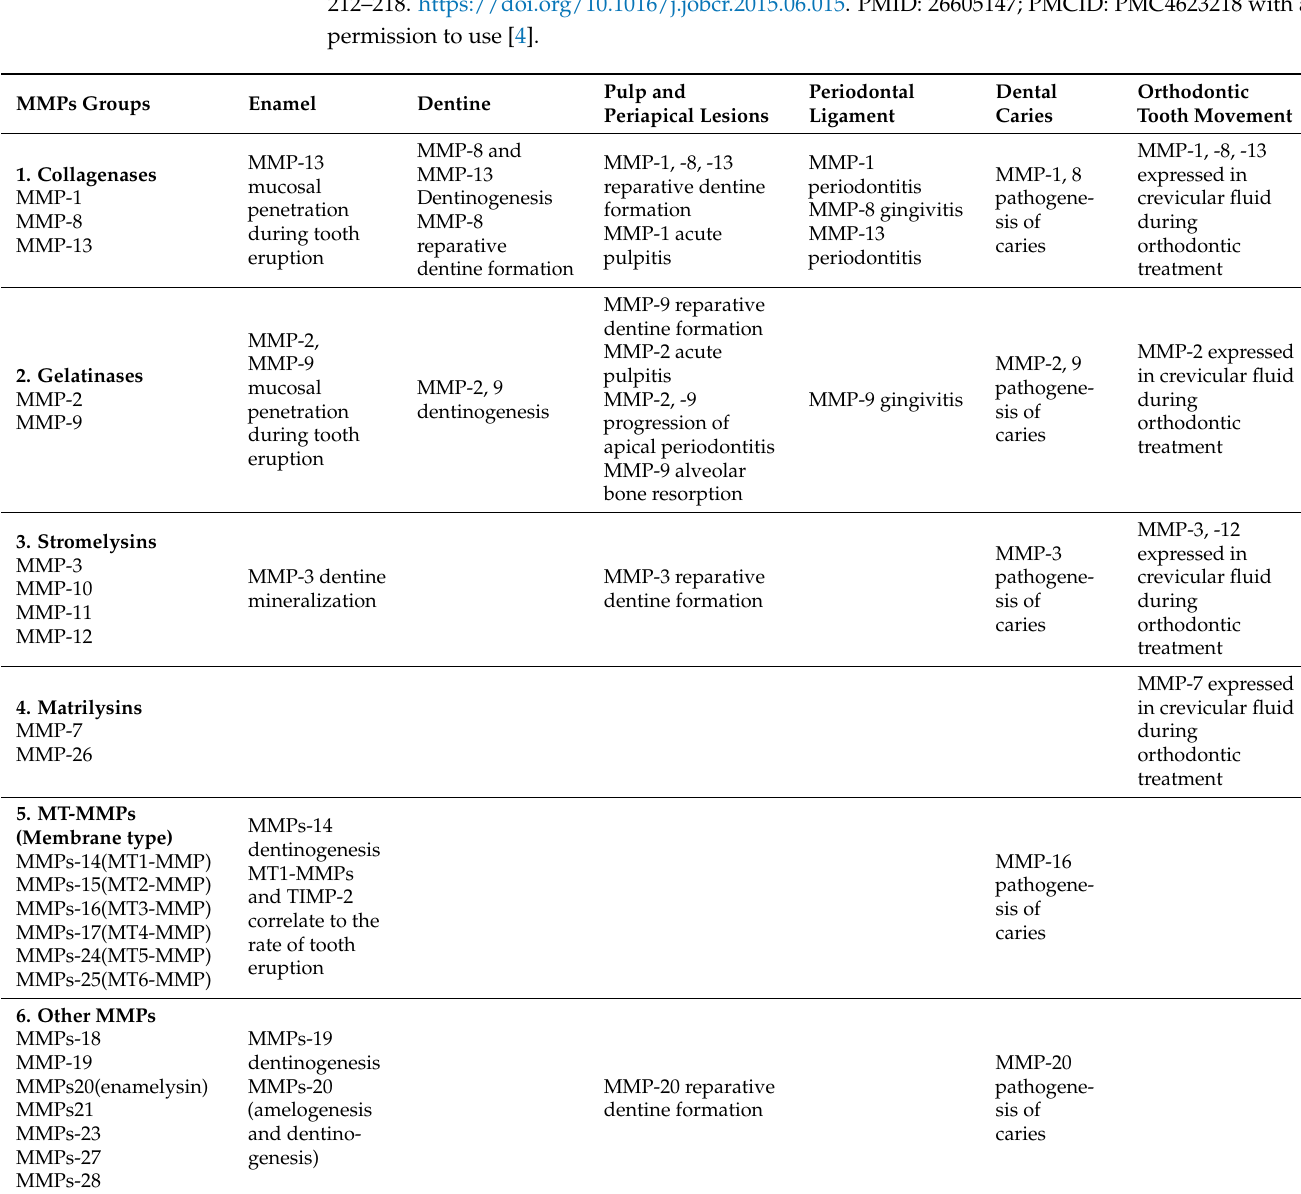
Table 2. MMP groups and their roles in dental and periodontal tissues and in orthodontic tooth movement. (MMP groups were used from Jain A, Bahuguna R. Role of matrix metalloproteinases in dental caries, pulp, and periapical inflammation: An overview. J. Oral Biol. Craniofac. Res. 2015 , 5 , 212–218. https://doi.org/10.1016/j.jobcr.2015.06.015. PMID: 26605147; PMCID: PMC4623218 with a permission to use